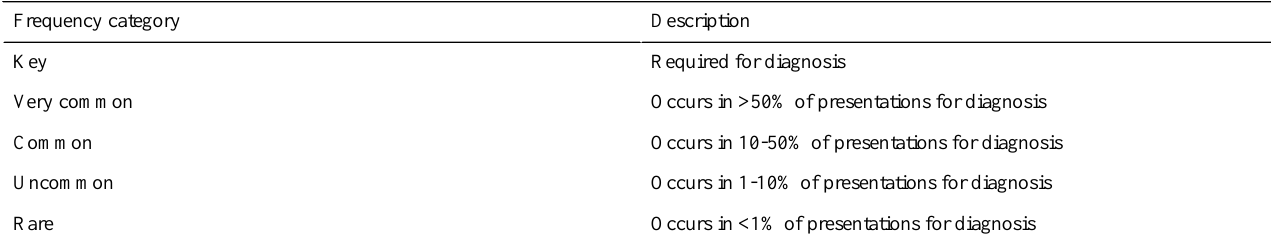
Table 2. cGPS’s physician-curated signs and symptoms frequency categories.